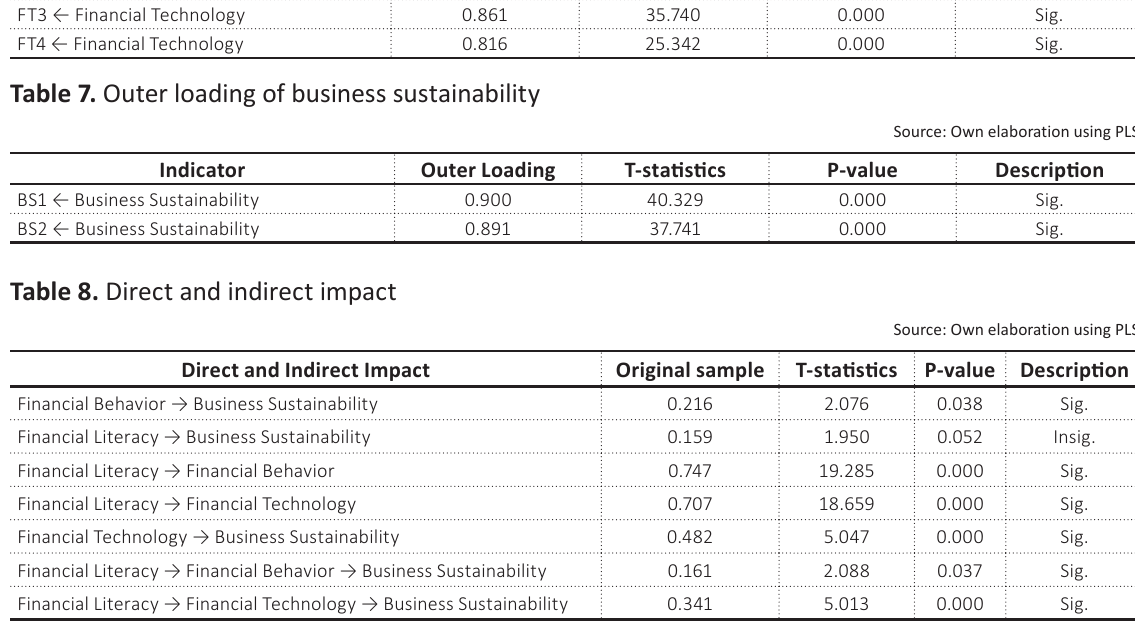
Table 7. Outer loading of business sustainability